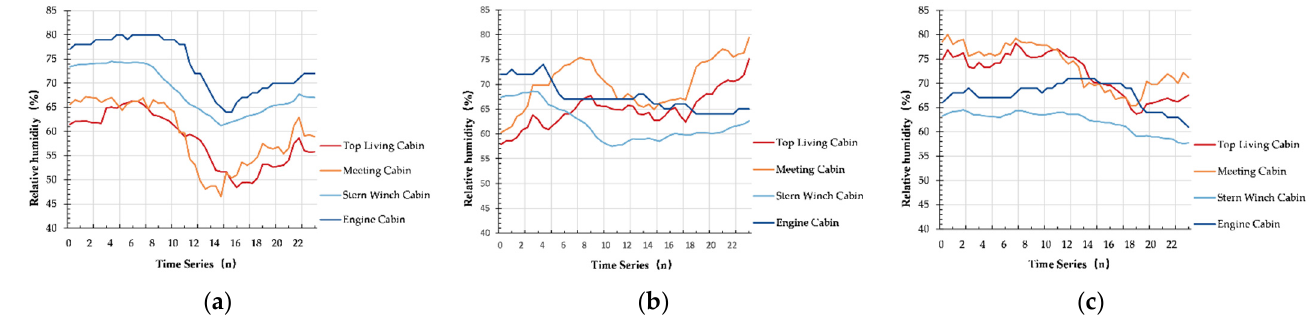
Figure 14. Relative humidity in the ship on ( a ) 4, ( b ) 5, and ( c ) 6 October 2021. Relative humidity is also affected by the environment, of which the influencing fac- tors are more complex [33,36]. On the whole, it shows an opposite trend to the changes in dry-bulb temperature. Although the variation in humidity also shows a correlation with temperature, it is not as obvious as the trend displayed by the temperature curve. Com- pared with the dry-bulb temperature curve, the variation in the relative humidity curve is more turbulent. For example, from 03:00 to 09:00 h on 5 December, the relative humidity curve, which fluctuated sharply in the short term, for the meeting cabin shows several local